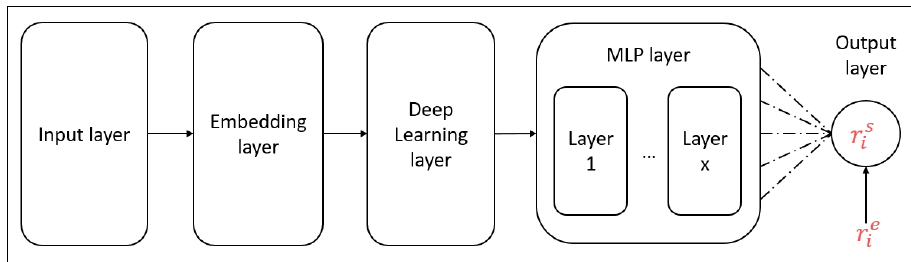
Figure 2. Architecture of the deep learning-based sentiment predictor.